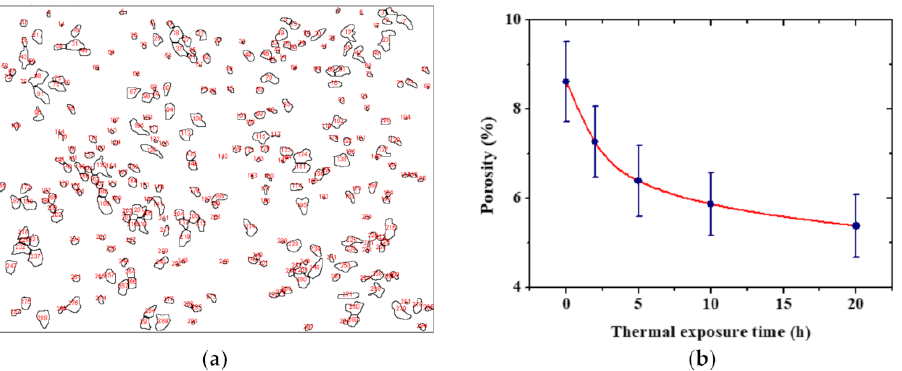
Figure 8. ( a ) Porosity distribution based on image analysis; and ( b ) curve between porosity and thermal exposure time.